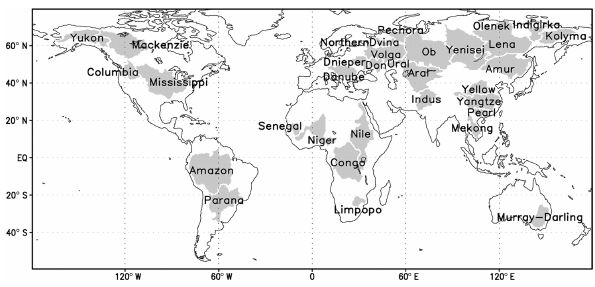
Figure 1. Locations of 32 selected large basins (Pan et al.,